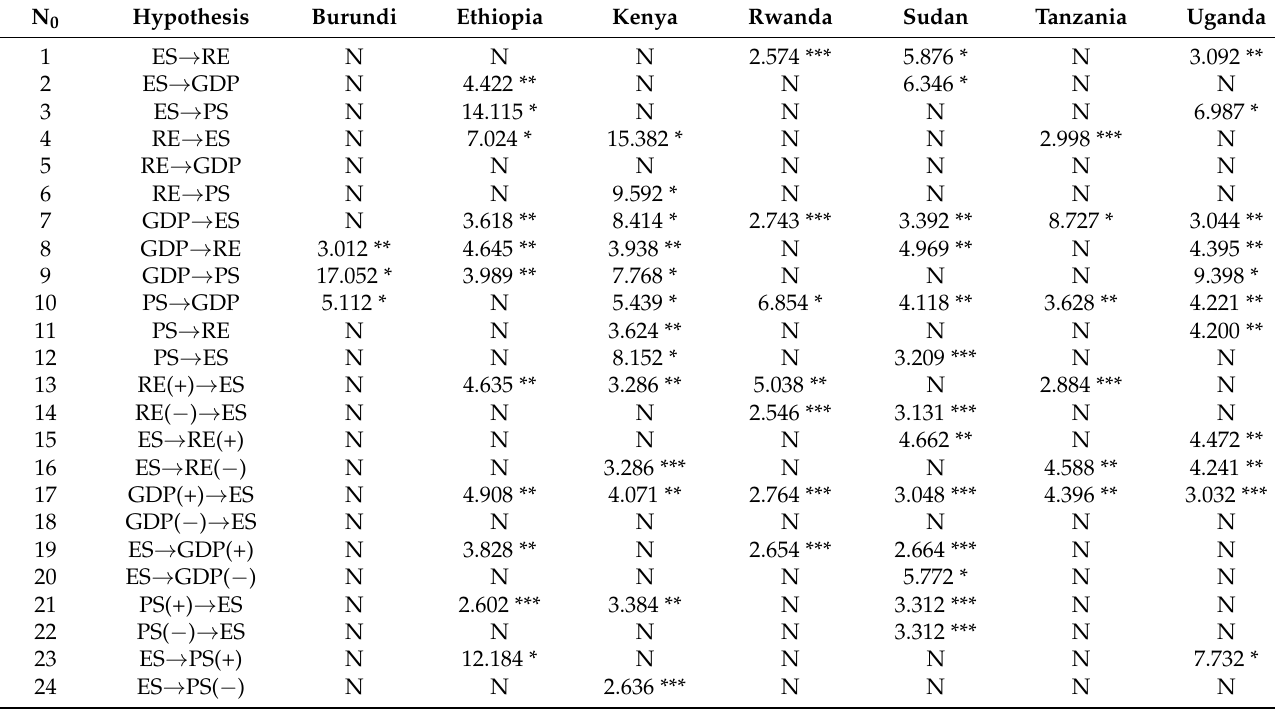
One-way directional causation running from population growth to GDP is noted in six countries; from population growth to renewable energy is noted in Uganda and Kenya; and from population growth to CO 2 is noted in Kenya and Sudan (rows 10, 11, and 12, respectively). Table 11. Causalities between CO 2 emissions, renewable energy, and economic and population growth. N 0